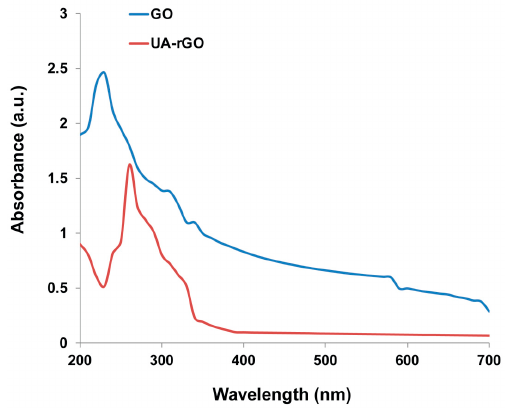
Figure 1. Synthesis and characterization of GO and UA-rGO by ultraviolet-visible spectroscopy.